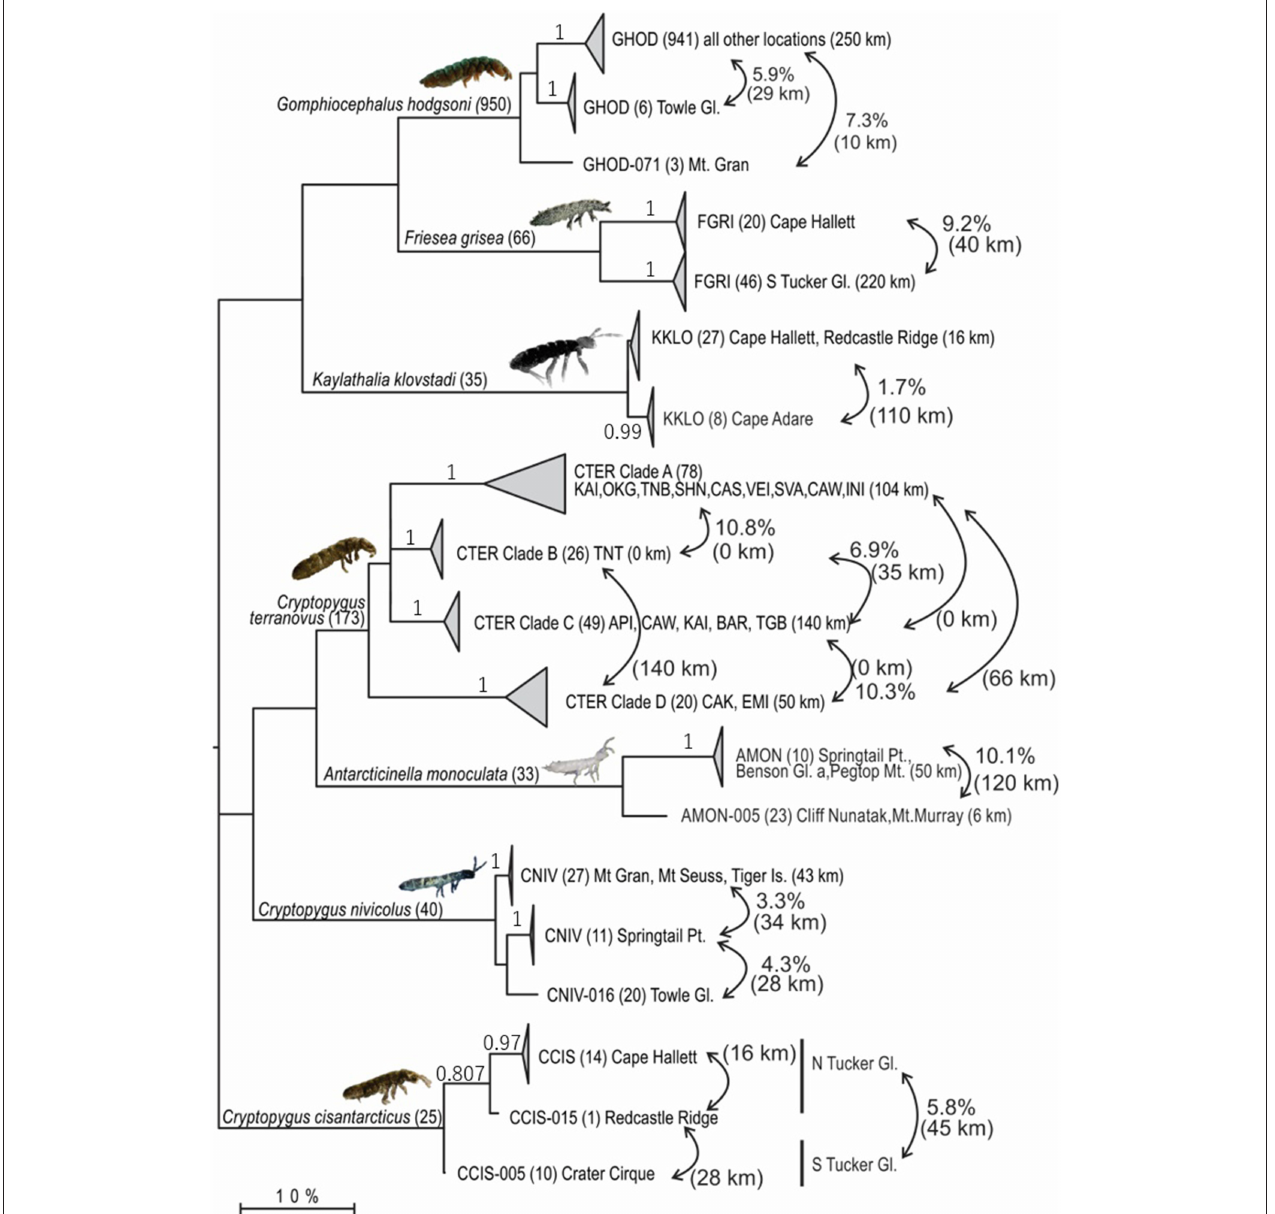
FIGURE 3 | Maximum Likelihood tree (GTR + Ŵ + I; 1,000 bootstrap replicates) based on the trimmed alignment (422 bp) for all 1,322 COI sequences available for the seven springtail species in Victoria Land. Clades are collapsed proportionately, where each collapsed clade represents a potential cryptic species ( > 1.7% divergence), and number of sequences are shown in parentheses. Geographic distances within and between clades are provided, along with p-distances between clades, to highlight geographical isolation of well-supported clades (bootstrap values provided on branches, where